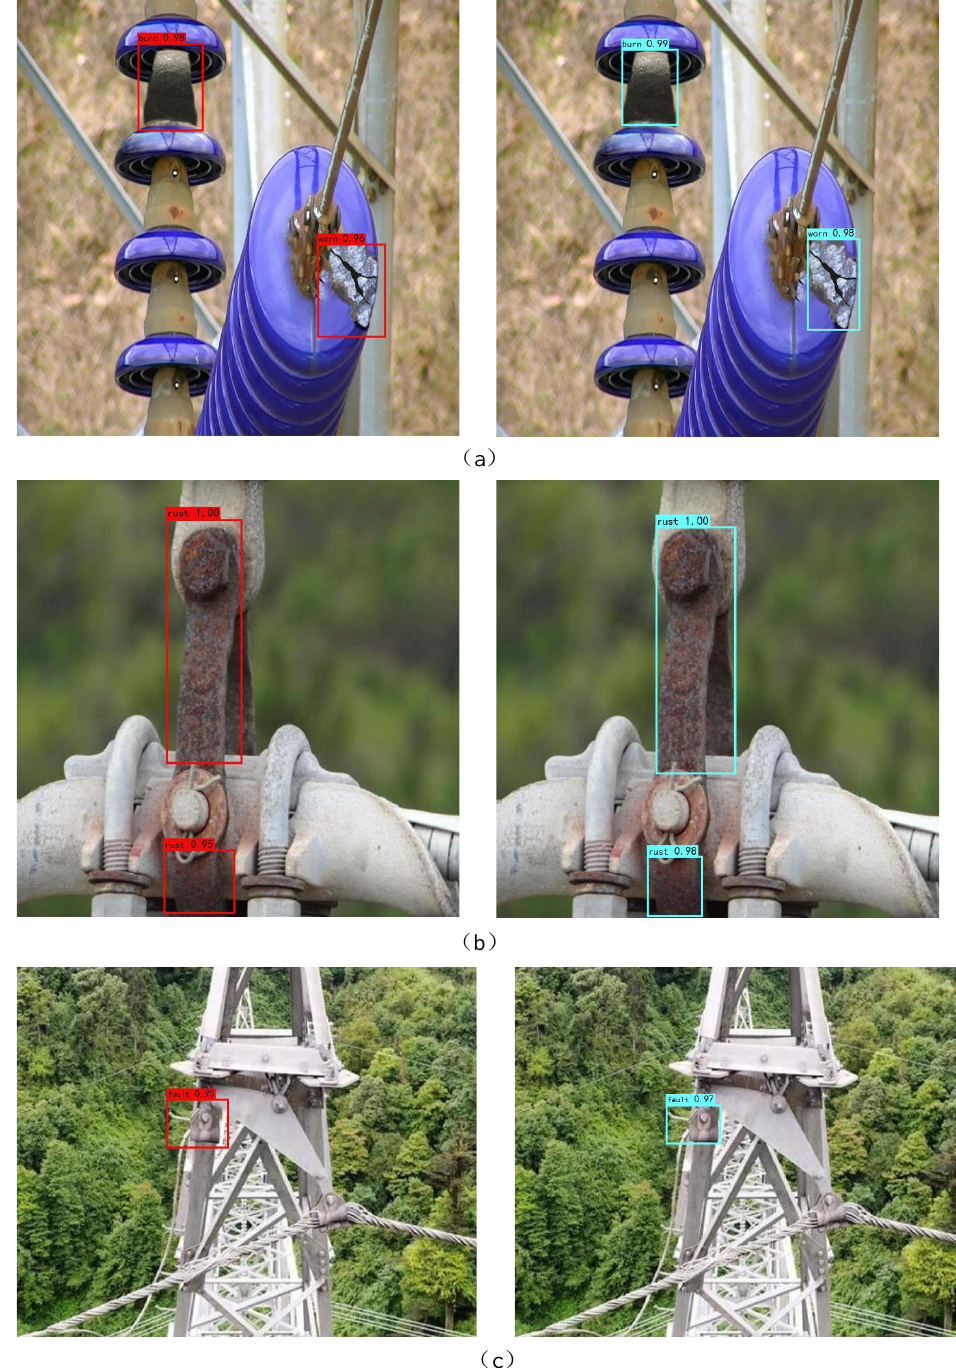
Figure 7. Defect detection results; ( a ) insulator, ( b ) wire clip and ( c ) hardware. Among them, the left side is the preliminary detection result, and the right side is the corrected result.